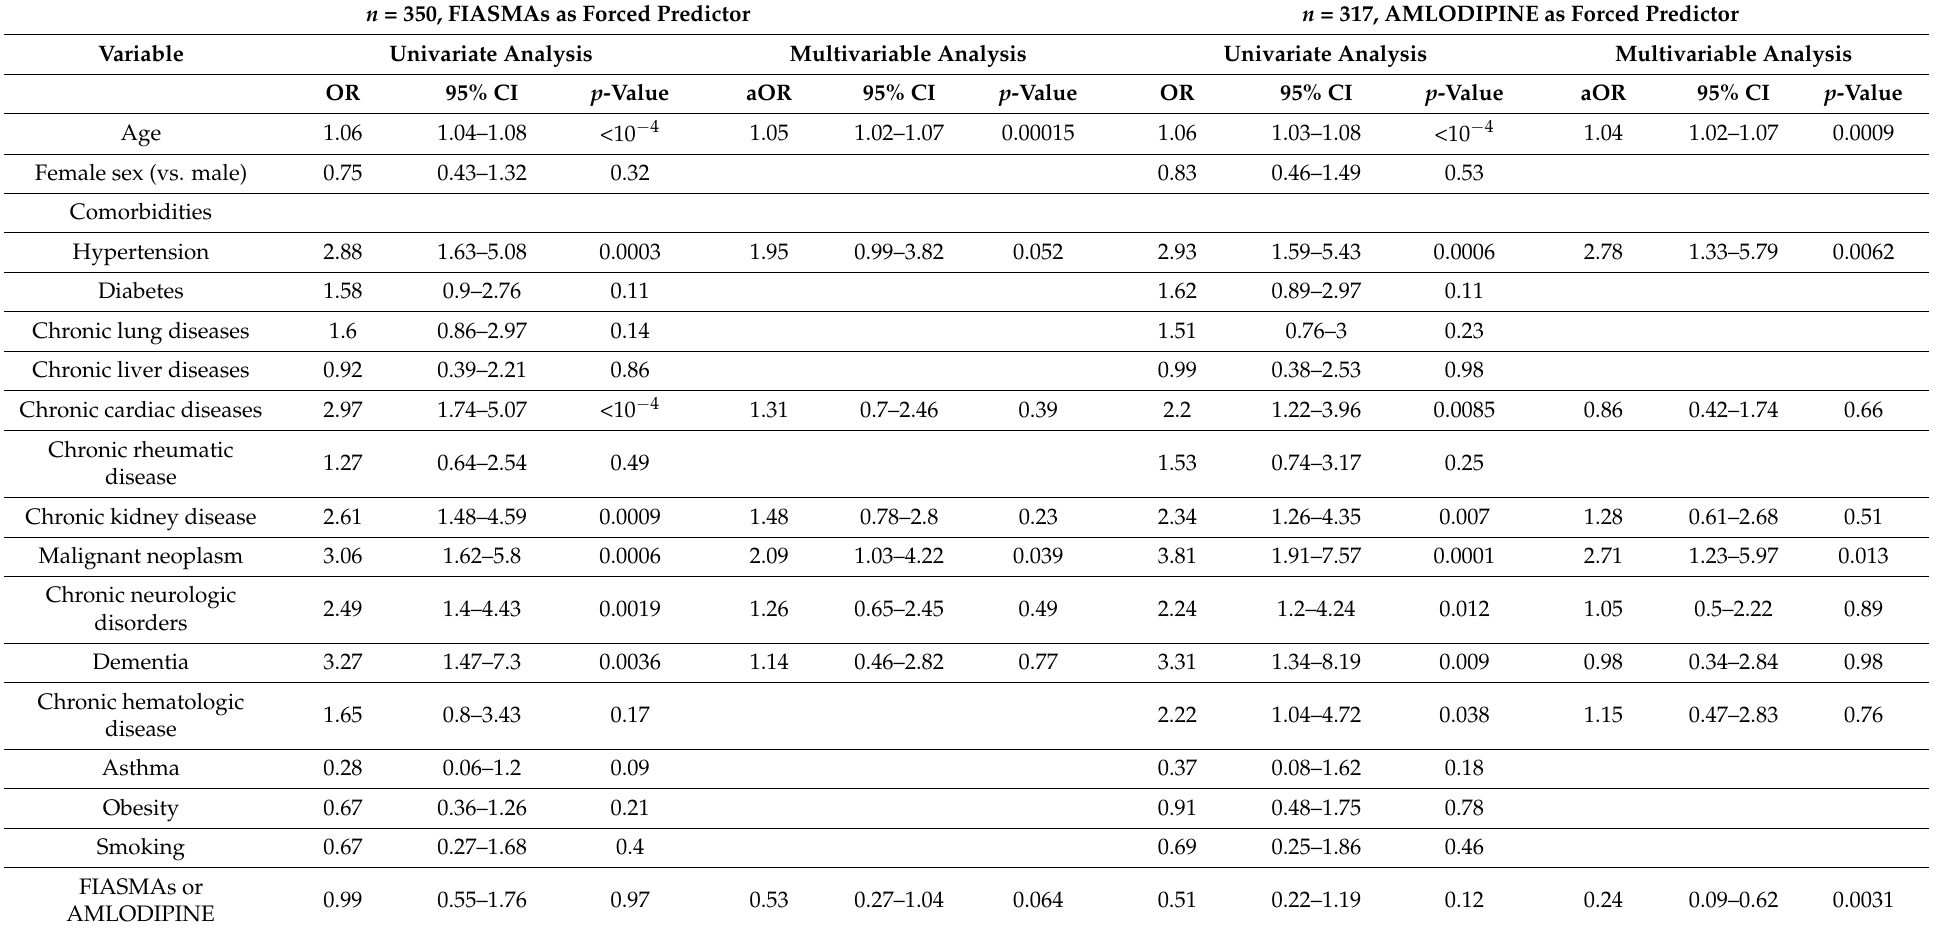
Table 2. Risk factors for mortality among COVID-19